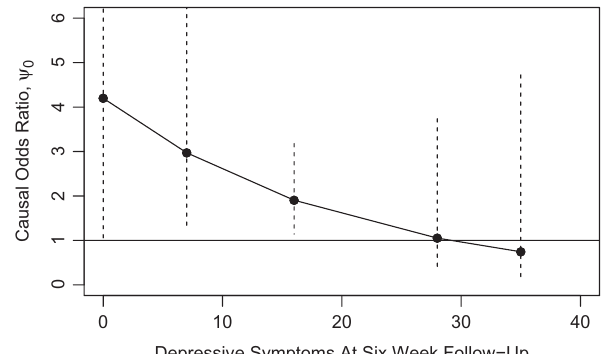
Figure 2: Causal odds ratio effect modified by depres- sion levels at six week follow-up. The dotted lines represent 95% confidence intervals. Point estimates calculated at the minimum, 25th percentile, median, 75th percentile, and 90th percentile on the depression scale